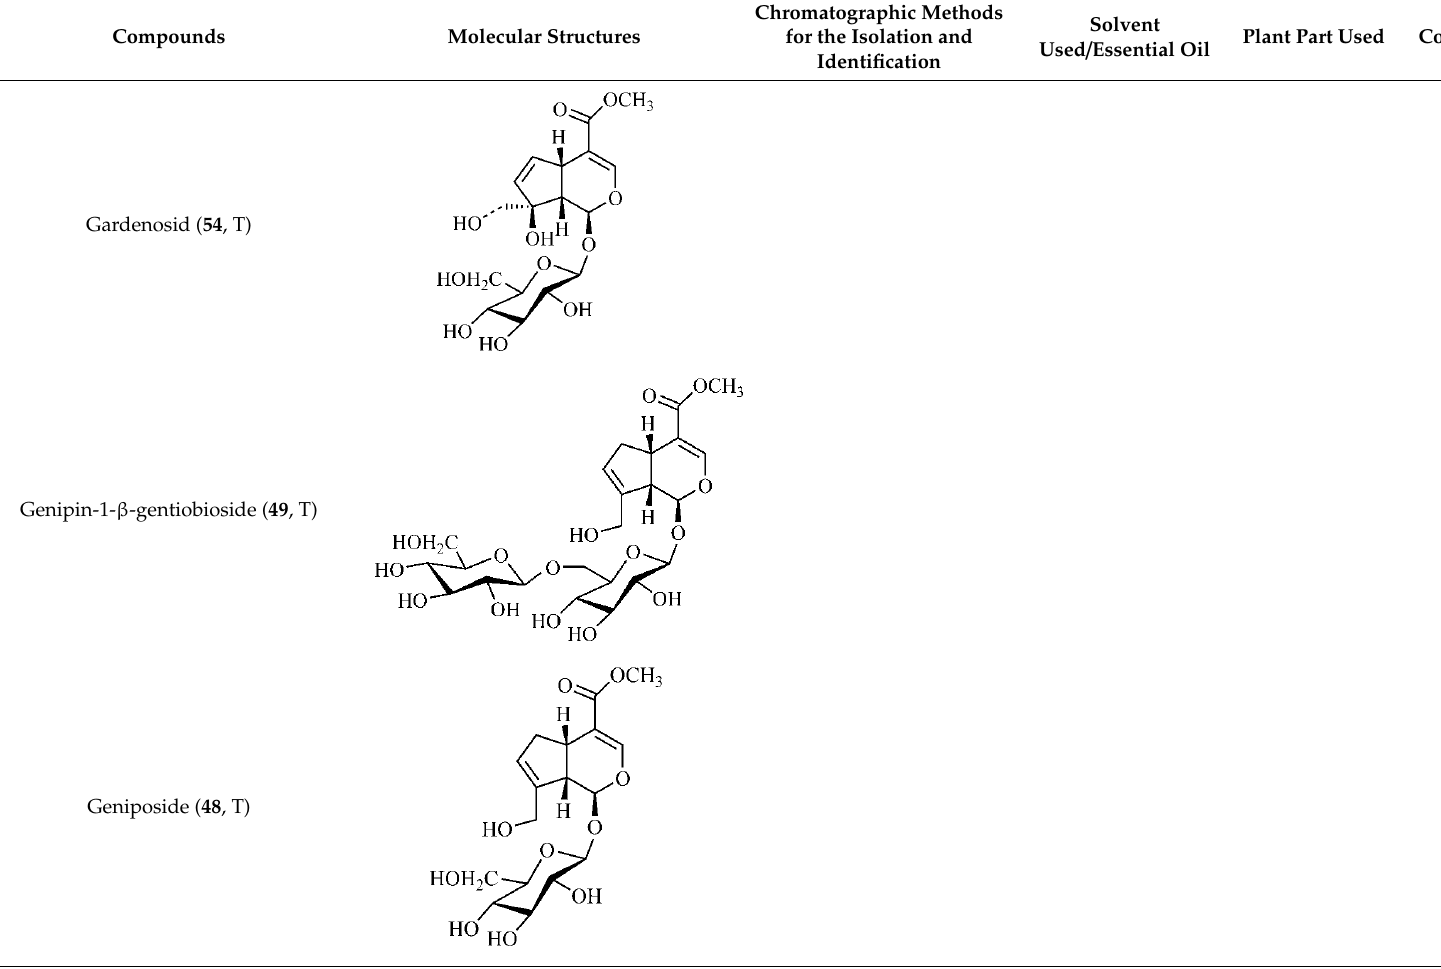
Table 3. Cont. Table 3.